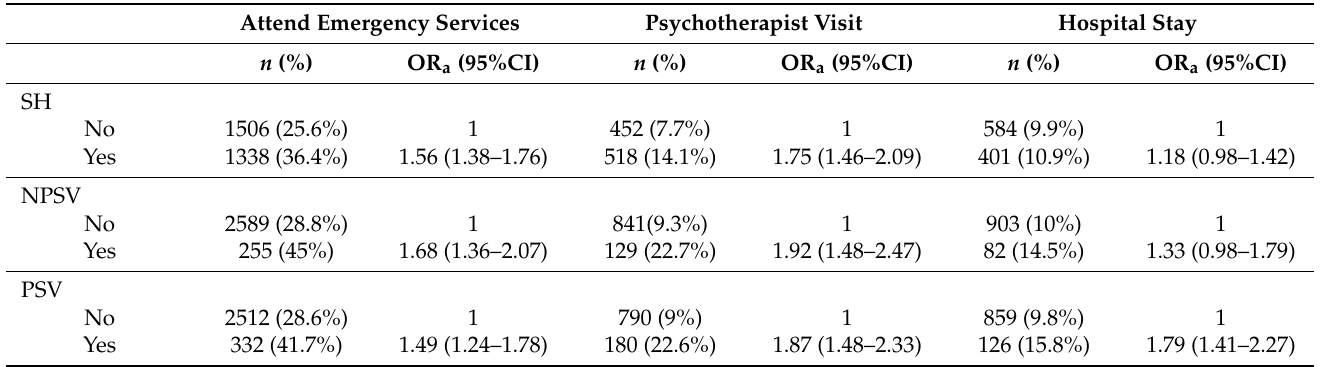
Table 4. Relationship between the types of sexual violence and indicators of their health impact with the use of health